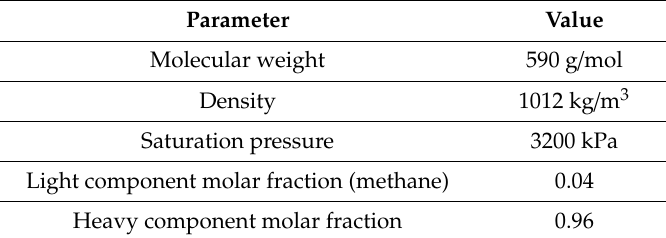
Figure 5. Location of the wells and cell sizes in the two-dimensional (2D) simulation model. Table 2. Fluid properties for the oil used in the simulation